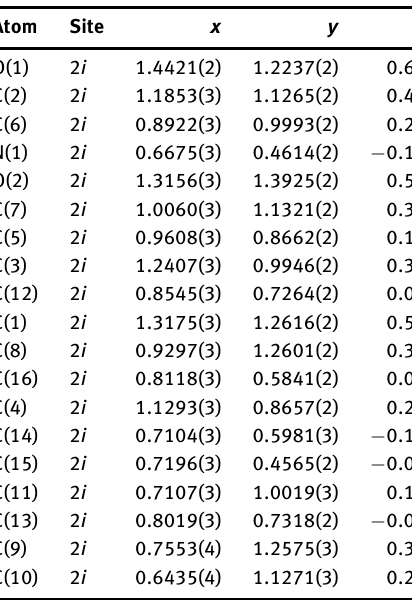
Table 3: Atomic displacement parameters (Å 2